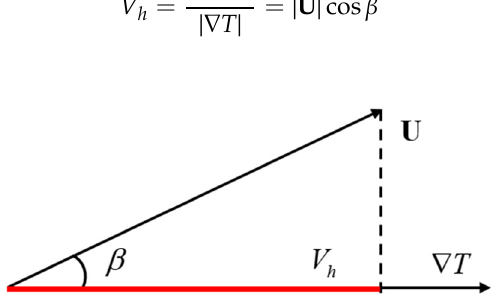
Figure 2. The definition of heat convection velocity.